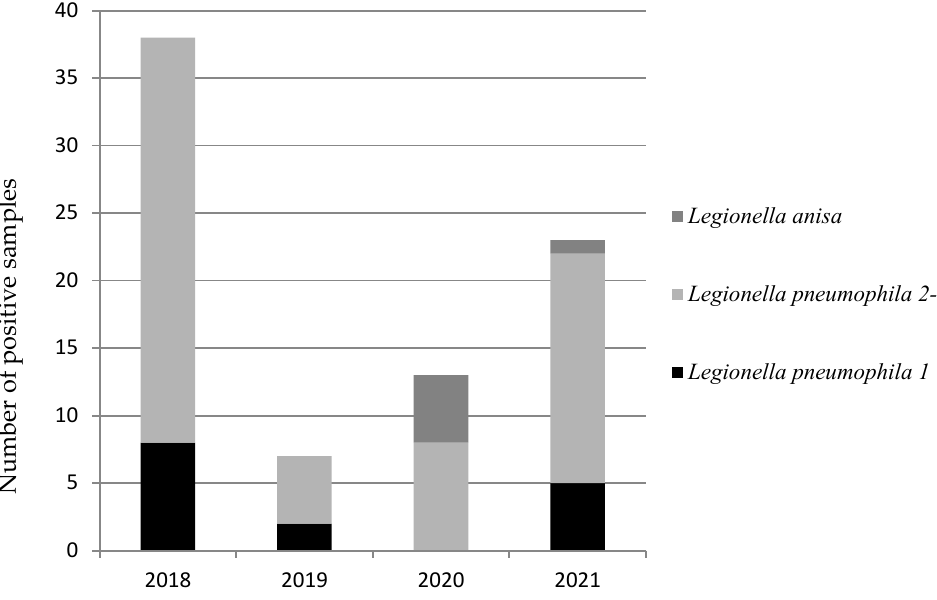
Figure 2. Trend recorded on a yearly basis during the four-year surveillance program reporting the number of positive isolates for L. pneumophila serogroups and L. anisa . The trend of isolates detected during the period of surveillance shows that L. pneu ‐ mophila sgr 2 ‐ 15 was present every year. The emergence of L. anisa for the past two years was also highlighted. From our data, 34.14% of the positive samples show the coexistence of different iso ‐ lates (Table 2). This is probably due to the ubiquitous contamination of Legionella in the water systems. As underlined in Figure 3, during 2018, there was a clear dominance of L. pneumophila sgr 1 and L. pneumophila sgr 2 ‐ 15; no coexistence was detected in 2019. In 2020, in four samples, we found the simultaneous presence of L. pneumophila sgr 1, L. pneumophila sgr 2 ‐ 15, and L. anisa . Finally, in 2021, the coexistence of L. pneumophila sgr 1 and L. pneumoph ‐ ila sgr 2 ‐ 15 became prevalent again. The total number of samples does not correspond to that reported in Table 1 because we found different Legionella serogroups and species in the same sample.